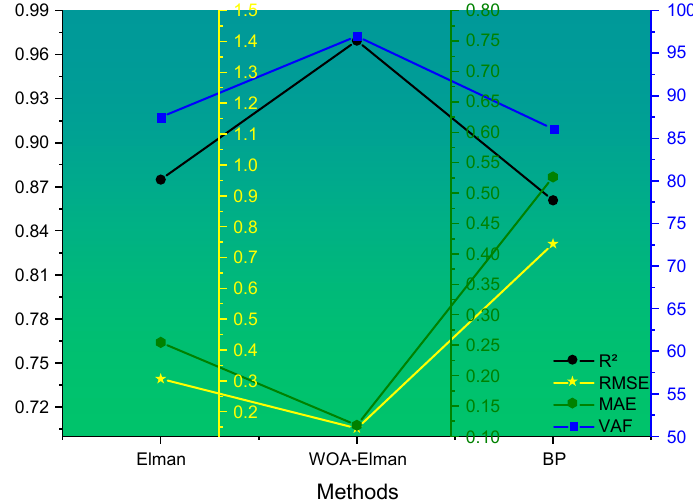
Figure 10. Line chart of evaluation index of prediction model.